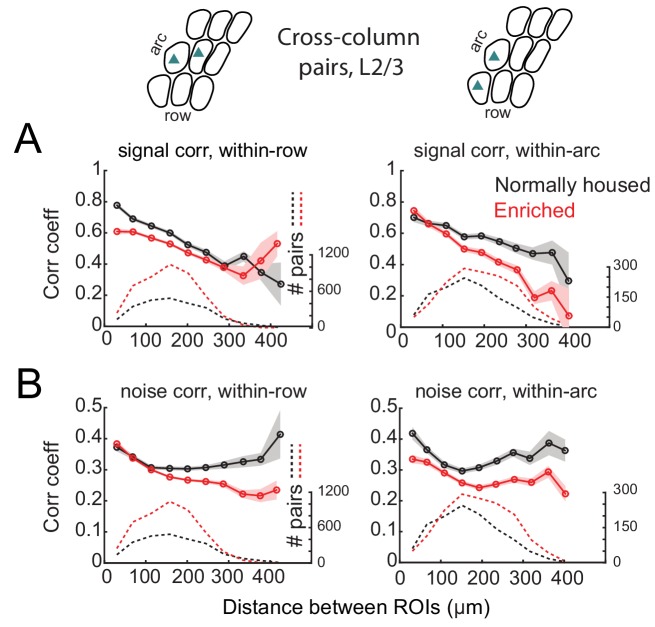
Spatial structure of signal and noise correlations across rows and arcs in L2/3.(A) Mean signal correlation across responsive L2/3 cell pairs located across columns as a function of inter-ROI distance, for cell pairs across columns within a row (left) or across columns within an arc (right). Shaded regions denote SEM. Dashed, number of cell pairs in each bin. Insets above plots show schematic of cell locations. (B) Mean noise correlation across all responsive L2/3 pairs located across columns within a row (left) or within an arc (right), plotted as in (A).